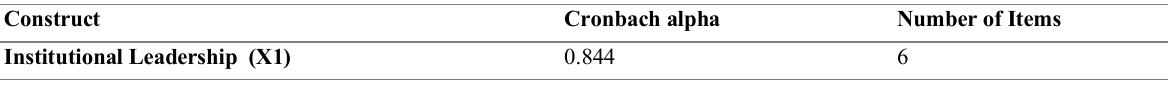
Table 2: Instrument